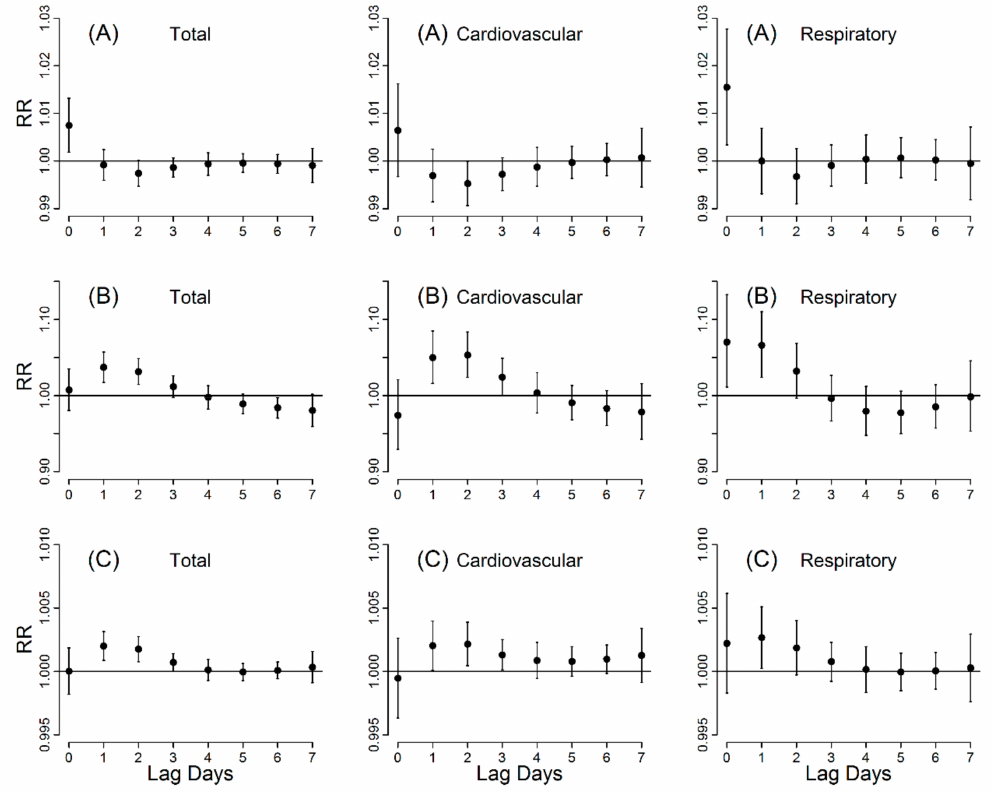
Figure 2. Relative risk (RR, 95% CI) for mortality with per 1 km decrease of visibility ( A ), in haze days ( B ) and per 10 µ g/m 3 increase of PM 10 concentration ( C ) at various lag days. The threshold of visibility was 10